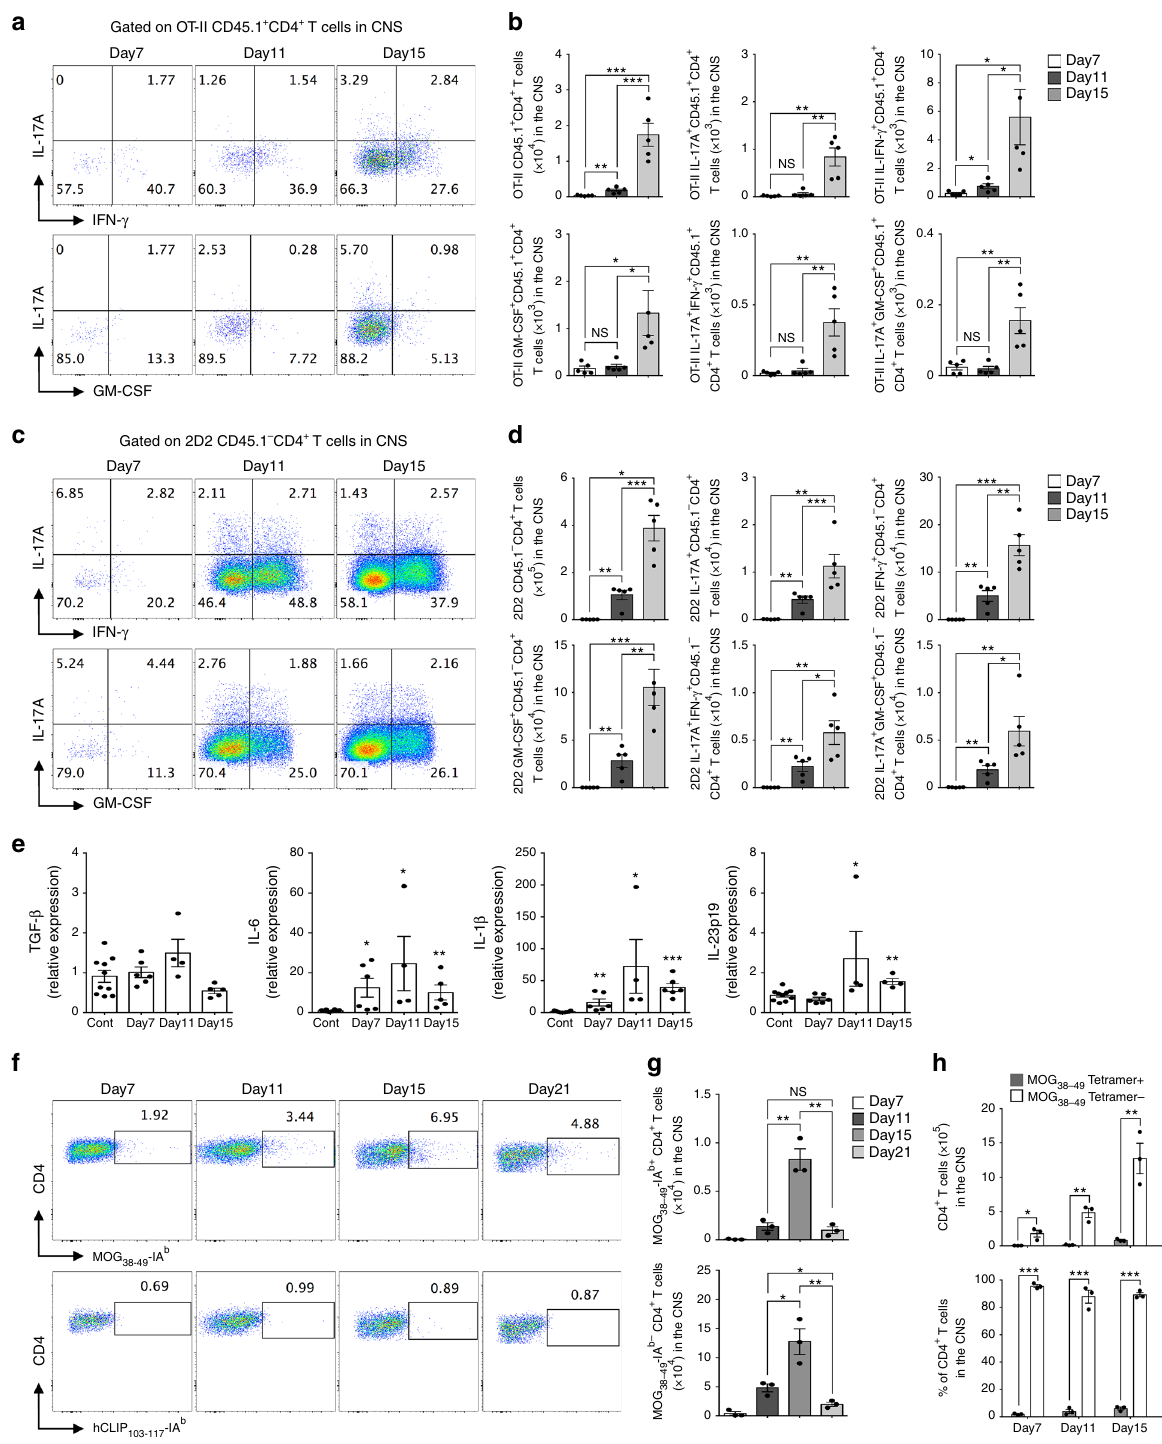
Fig. 5 Kinetics of myelin-speci fi c and non-related CD4 + T cells in fi ltration into the spinal cord during the development of EAE. a – d Naive CD4 + T cells from MOG – TCR-transgenic (2D2) mice were adoptively transferred with in vitro-cultured OT-II memory-like T H 17 cells into Rag2 − / − mice and immunized with MOG in complete Freund ’ s adjuvant. a The proportion and b absolute cell number of spinal cord-in fi ltrating cytokine-producing OT-II CD45.1 + CD4 + T cells was analyzed on day 7 (score 0.5 – 1), day 11 (score 2 – 2.5), and day 15 (score 3 – 4) after immunization. c The proportion and d absolute cell number of spinal cord-in fi ltrating cytokine-producing 2D2 CD45.1 - CD4 + T cells was analyzed. e The levels of mRNAs encoding cytokines TGF- β , IL-6, IL-1 β , and IL- 23p19 were analyzed in the spinal cord by quantitative real-time PCR. f – h EAE was induced in 8-week-old female C57BL/6 mice by immunization with MOG in CFA. f MOG 38-49- IA b tetramer staining of CD4 + T cells in the spinal cord as determined by fl ow cytometry. g , h The proportion and absolute cell number of spinal cord-in fi ltrating CD4 + T cells was analyzed on day 7 (score 0.5 – 1), day 11 (score 2 – 2.5), day 15 (score 3 – 4), and day 21 (score 1 – 2) after immunization. Data are presented as the mean ± SEM of two independent experiments. NS, not signi fi cant; * p < 0.05, ** p < 0.01, *** p <